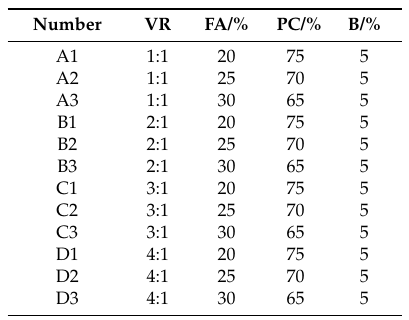
Table 3. Proportion of mixture of experimental grout. VR: Volume ratio; FA: Fly ash; PC: Portland